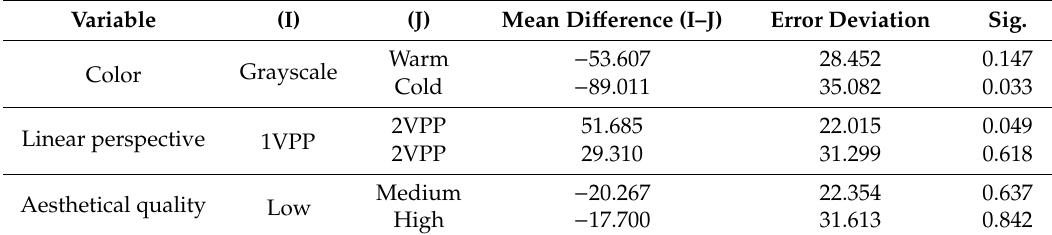
Table 3. Tukey test results (dependent variable: likes).